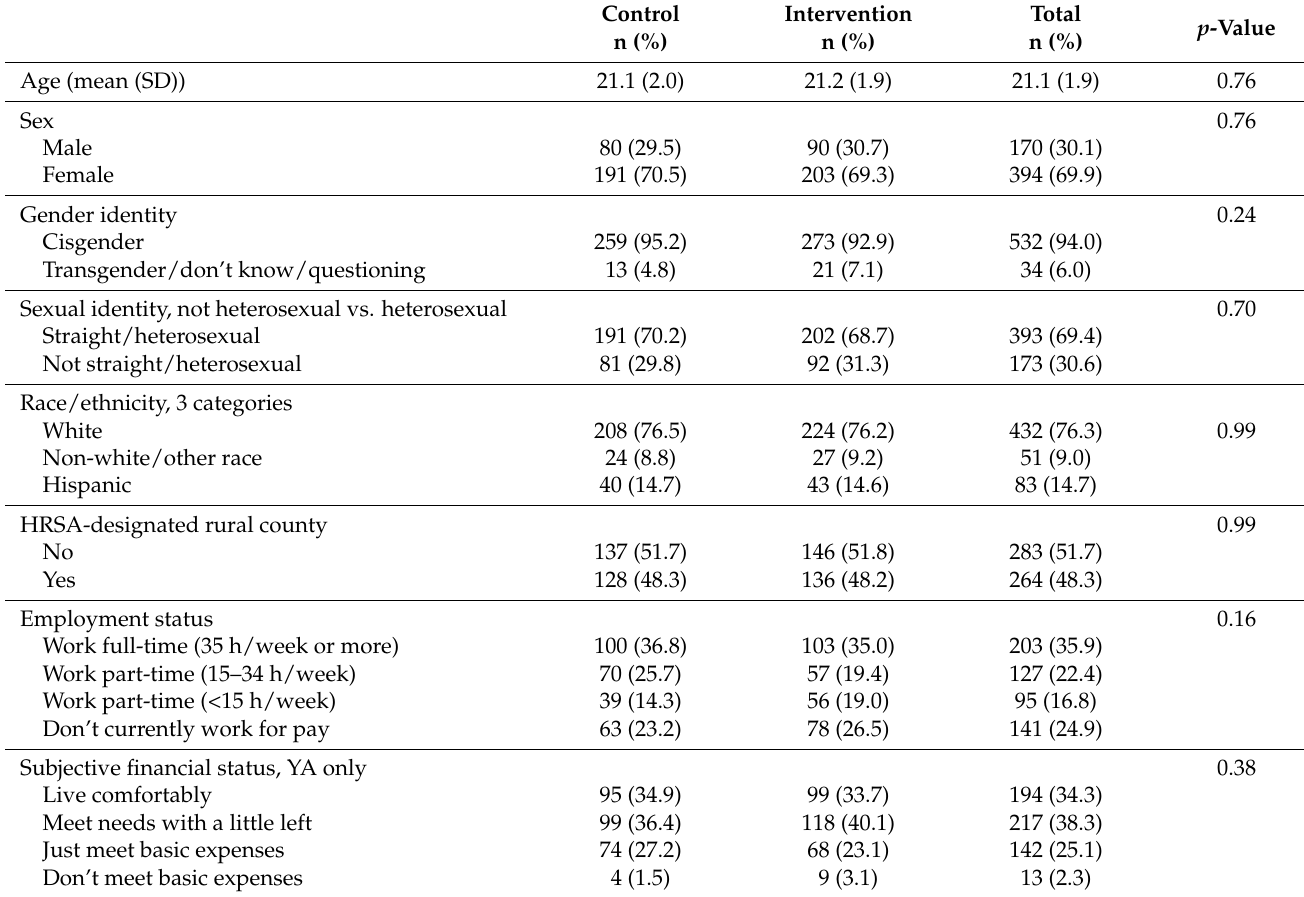
Table 1. Sample characteristics, PACE Vape Messaging Study, 2020.